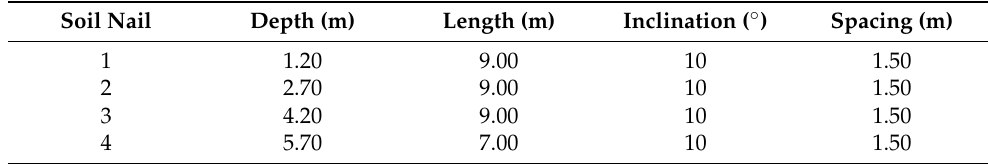
Table 3. Design parameters of soil-nailed retaining structures.